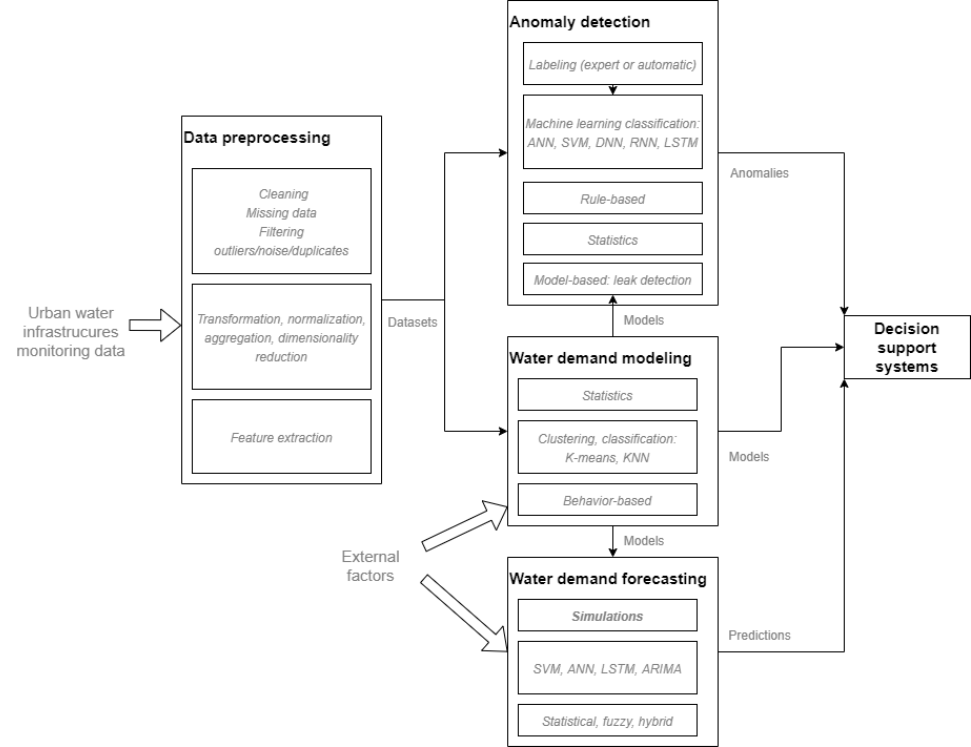
Figure 5. Data analysis techniques in water